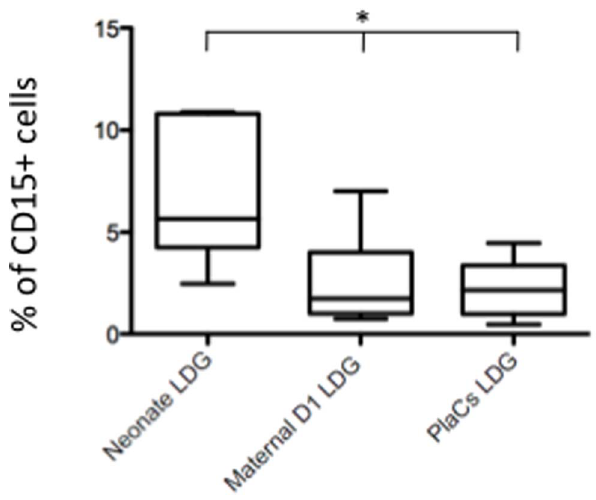
Figure 3. Percentage of LDGs in neonatal and maternal blood and placentae. LDGs were isolated as described in materials and methods (n=7) and the percentage of CD15 + arginase + cells was determined by flow cytometry. The percentage of LDGs present in the peripheral blood of healthy controls was 0.24 6 0.3 [12] Statistical significance was determined by a kruskal-Wallis test. Box=interquartile range and median; whiskers=range.